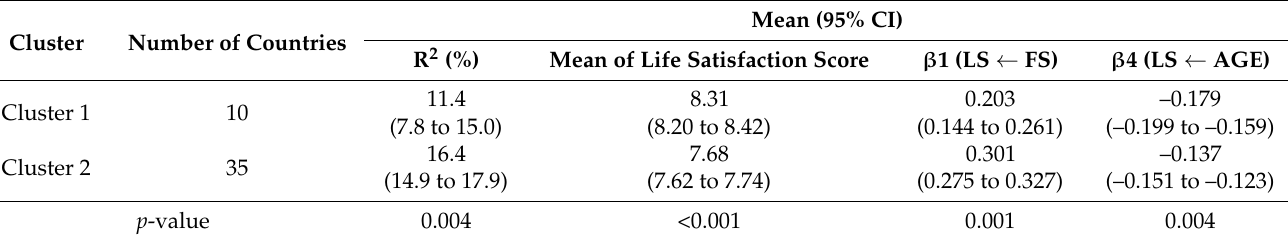
Table 9. Comparison of country